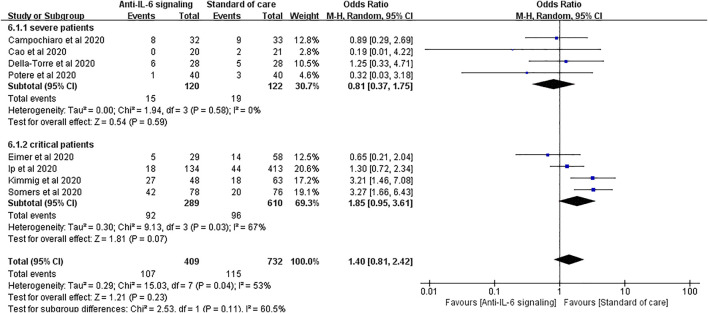
Subgroup analysis according to severity of patients with COVID-19 for pooled odds ratio of secondary infections. Four studies were included in the subgroup of patients with severe disease, including 120 patients treated with IL-6 signaling inhibitors and 122 patients treated with SOC. There was no significant difference in terms of risk of infection between groups (pooled OR = 0.81, 95% CI 0.37–1.75, p = 0.59). Four studies were included in the subgroup of patients with critical disease, including 289 patients treated with IL-6 signaling inhibitors and 610 patients treated with SOC. The risk of secondary infections tended to be greater in the subgroup of patients with critical disease treated with anti-IL-6 signaling agents than in those treated with SOC (pooled OR = 1.85, 95% CI 0.95–3.61, p = 0.07), though it did not reach statistical significance.